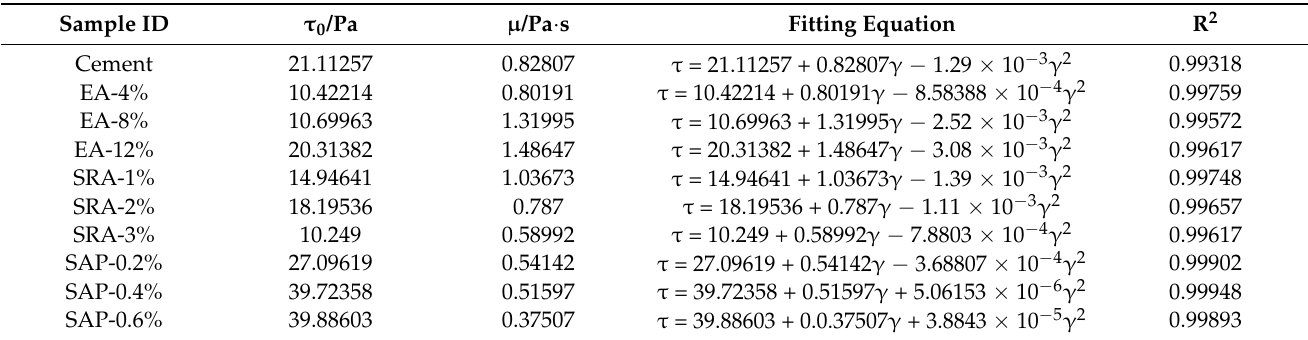
Table 3. Rheology parameters of compound